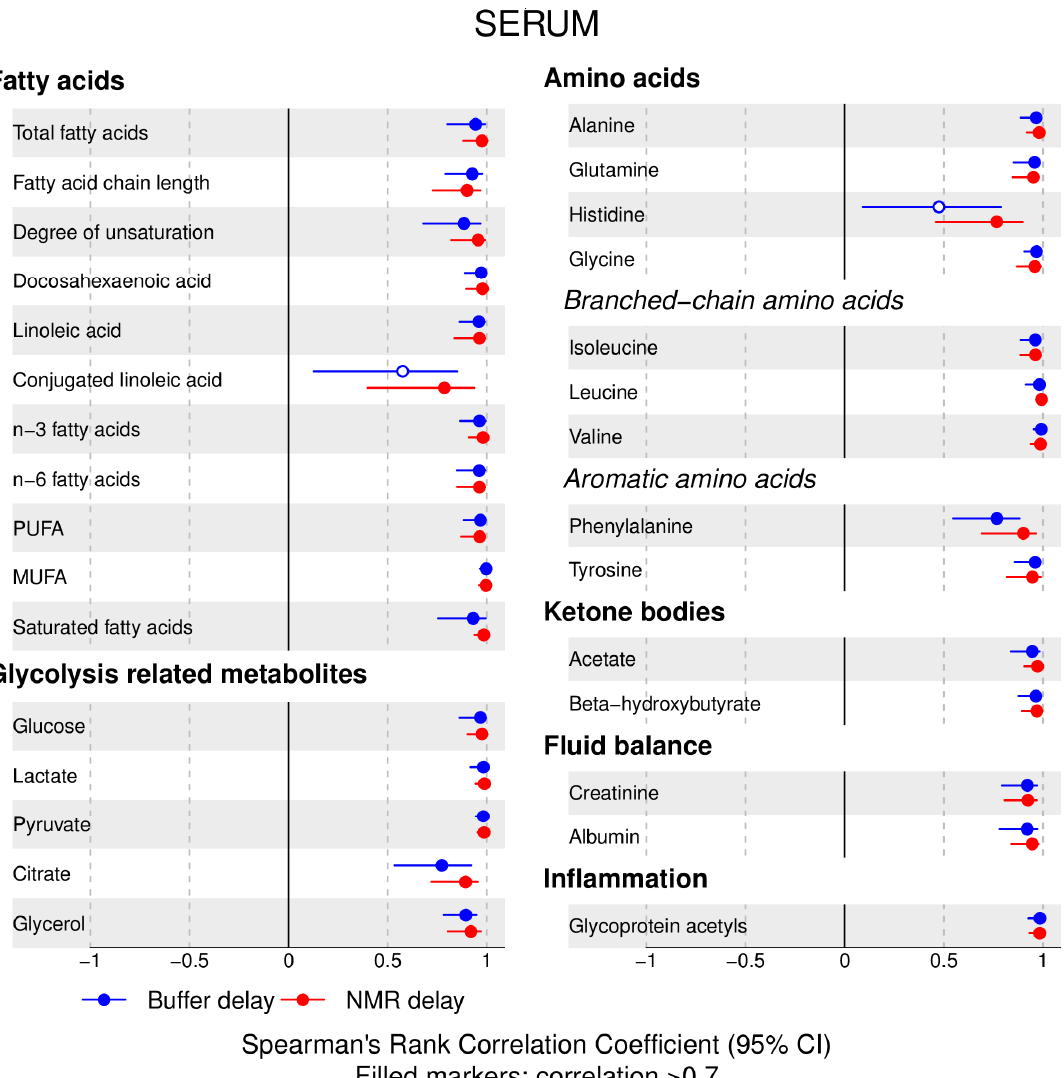
Figure 6. Serum, post-storage handling effects (Figure 5 continued): Spearman’s rank correlation coefficients between metabolic trait concentration/value in reference samples (no sample preparation or nuclear magnetic resonance (NMR) analysis delays) and samples subjected to two variant post-storage conditions in which samples thawed overnight and afterwards (i) were left for 24 h before addition of sodium buffer followed by immediate NMR analysis (buffer delay); and (ii) addition of sodium buffer, then left for 24 h before profiling (NMR delay) (correlations for lipoprotein trait details are given in Figure S3, Supplementary Materials). Spearman’s rank correlation coefficients and 95% confidence intervals (CIs) are listed in Table S4, Supplementary Materials. MUFA, monounsaturated fatty acids; PUFA, polyunsaturated fatty acids.